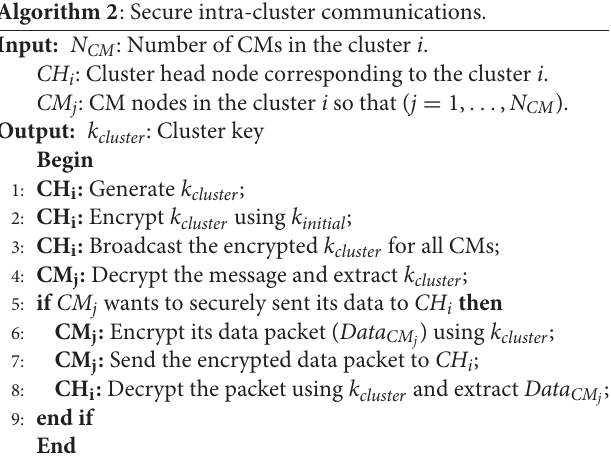
Algorithm 2 : Secure intra-cluster communications.